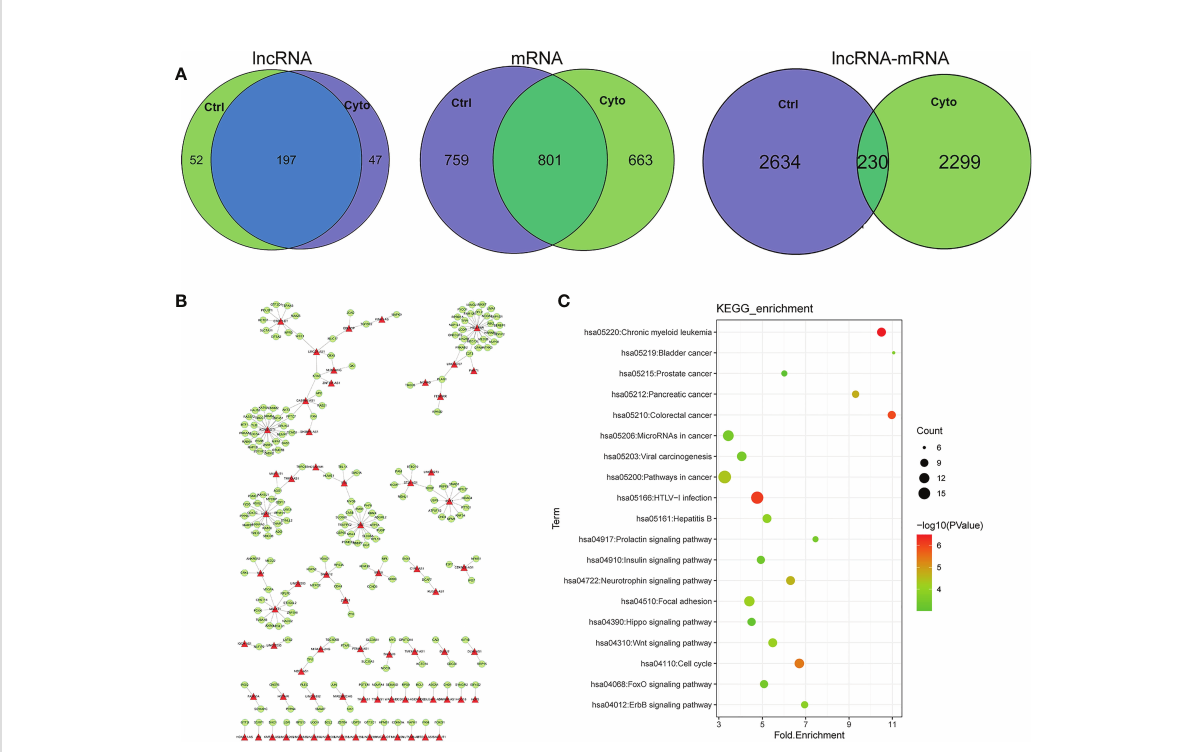
FIGURE 3 (A) Comparison of lncRNA, mRNA and lncRNA-mRNA regulatory relations in different network of exosomes. ctrl: Function enriched for mRNAs in network without cytokines stimulation; cyto: Function enriched for mRNAs in network with cytokines stimulation. (B) Competitive regulation of lncRNA-mRNA shared in networks of two states. (C) Function of enrichment for